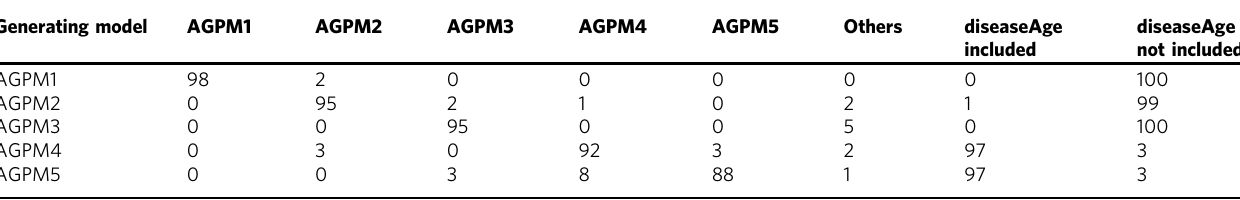
Table 1 Model inference results